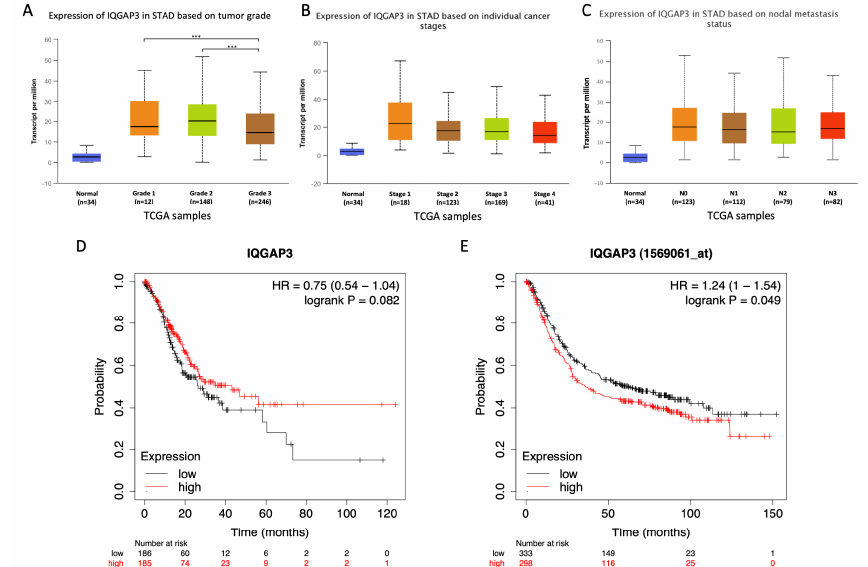
Figure 2. Expression of IQGAP3 and overall survival rate in patients with low and high IQGAP3 expression in the TCGA database. ( A – C ) Expression of IQGAP3 in patients with different tumor grades, cancer stages, and nodal metastasis status as compared with normal controls. Of note, all the tumor subgroups in A – C had statistically significantly higher IQGAP3 expression compared to normal controls (***, p < 0.001) (blue boxes). Overall, no significant differences among subgroups were identified. ( D and E ) Kaplan–Meier plots showed no statistically significant differences in overall survival using the RNA-seq dataset ( D ). However, statistically significant poorer overall survival was observed in patients with higher IQGAP3 expression when using a microarray dataset ( E ). The median value of IQGAP3 expression was selected as a cut-off for low and high expression in 2 D and 2 E .